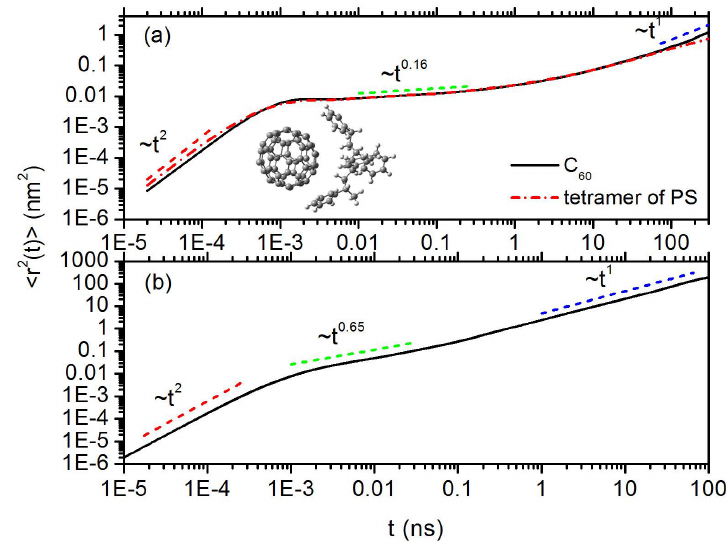
Figure 5. The centre-of-mass MSDs (solid lines) for C 60 NP in: ( a ) PS melt; and ( b ) PP melt. The inset in ( a ) shows an example configuration where C 60 NP is chelated by two phenyl rings on PS chain backbone. Dash dot line in ( a ) is the MSD of the tetramer on PS